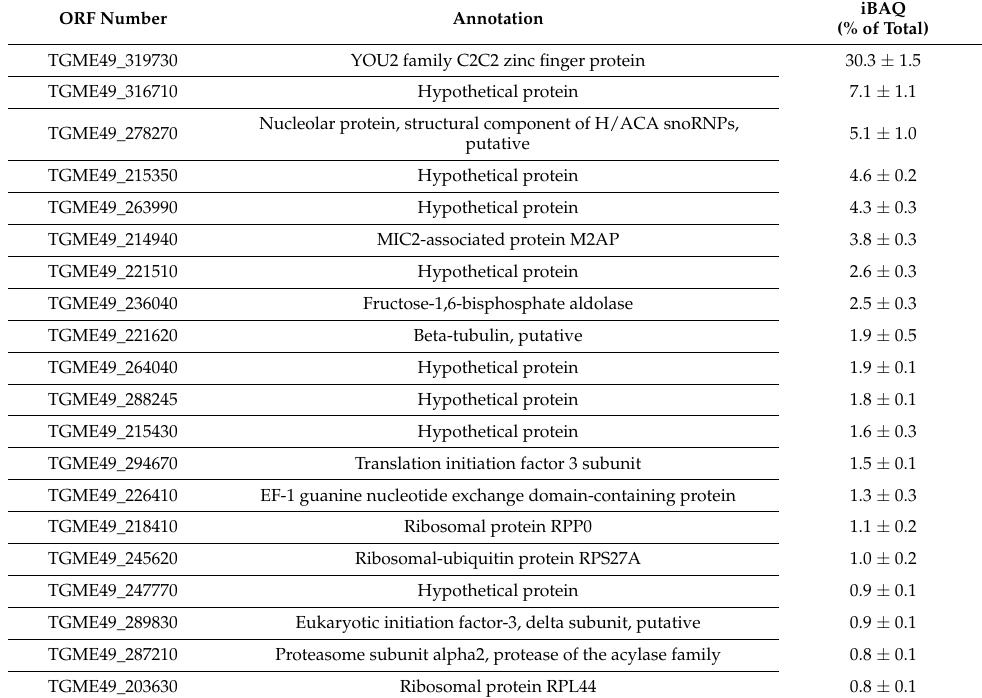
Table 2. List of the 20 most abundant proteins from T. gondii ME49 specifically binding to the com- pound 1 column, as identified by differential affinity chromatography followed by mass spectrometry. See Table S1 for the full dataset. The abundance is given as the percentage of the iBAQ values, with 100% being the sum of the iBAQ values of all 122 proteins specifically binding to 1 . Mean values ± standard errors of three replicates are